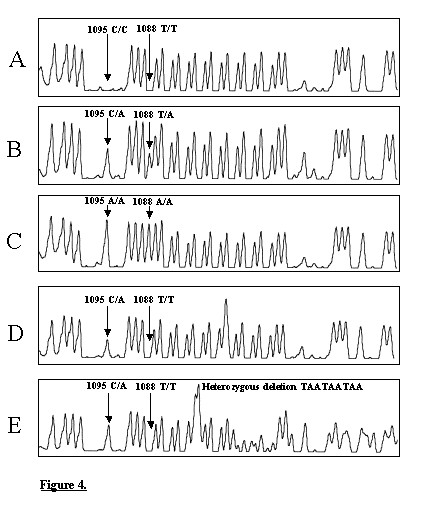
NAT1 alleles in 3'-untranslated region by single A-track sequencing on ABI310 PRISM. Displayed area from A1104 to A1048. (A) NAT1*4/*4 – wild type; (B) 1088T/A and 1095C/A heterozygote; (C) 1088A/A and 1095A/A homozygote; (D) 1088T/T homozygote and 1095C/A heterozygote; (E) NAT1*4/*11 allele.